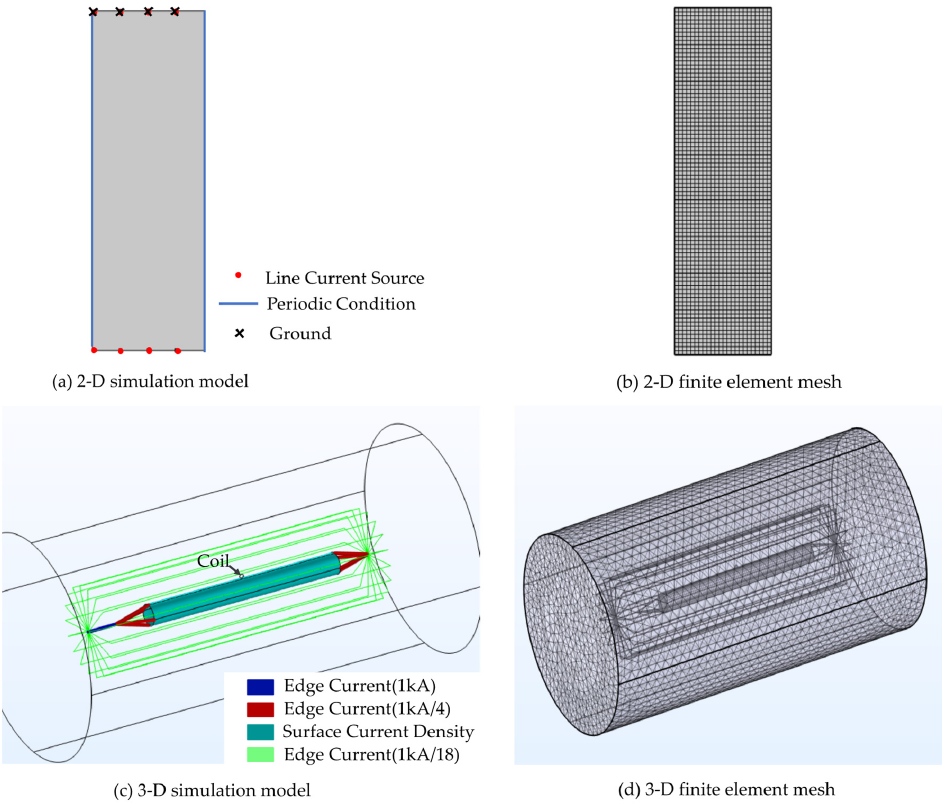
Figure 9. Numerical model of calibration system including excitation settings for 2-D model ( a ), and 3-D model ( c ), mesh setup for 2-D model ( b ), and 3-D model ( d ).